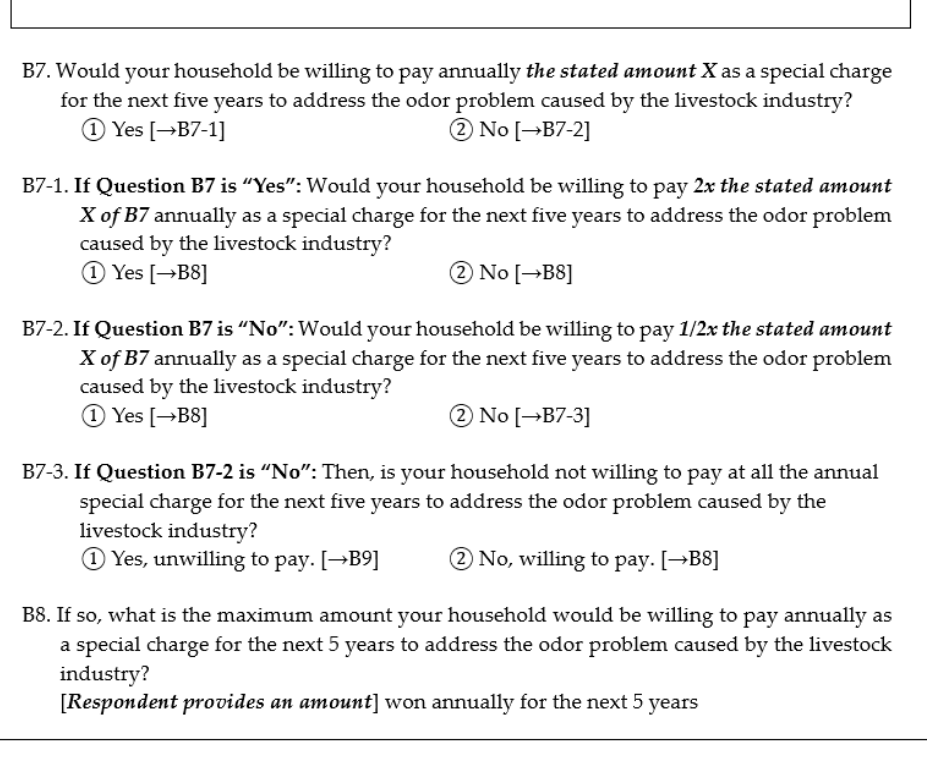
Figure 2. S ample double-bounded dichotomous choice questions for a respondent’s WTP . Figure 2. Sample double-bounded dichotomous choice questions for a respondent’s